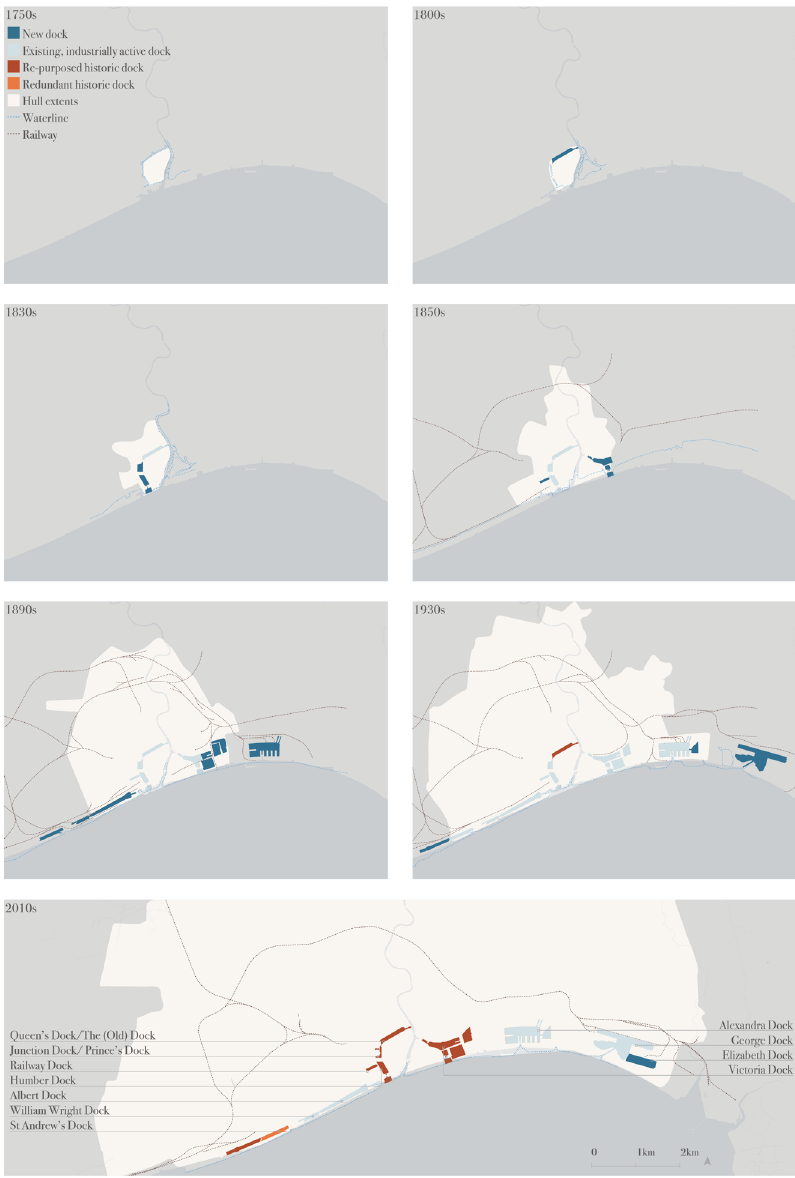
Diagrammatic representation of the evolution of Hull’s Waterfront from the Middle Ages to future plans, reproduction drawing by author, 2020. [reproduced with GIS Data provided by OS Meridian 2,